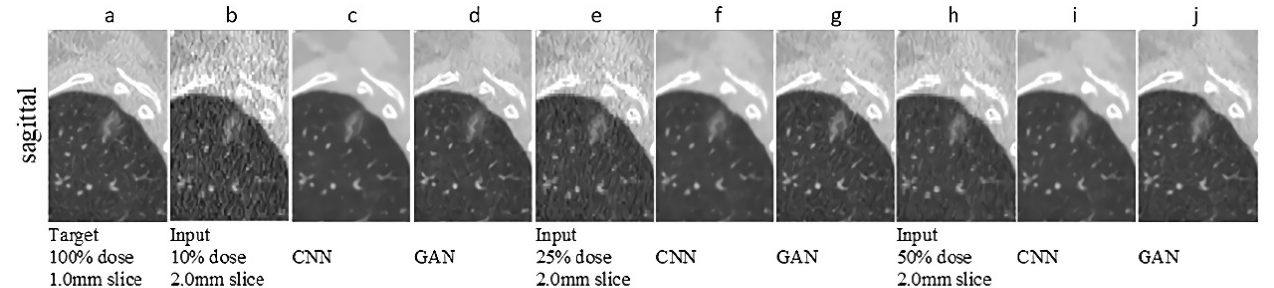
Figure 4. Normalization results reused from [87] with original copy obtained from authors. The row represents a sagittal view of the scans containing the ROI nodule. Column ( a ) represents the target image; Column ( b , e , h ) shows the input images with different slice thicknesses and dosage; Columns ( c , f , i ) show the CNN results and Columns ( d , g , j ) show the GAN-based results.